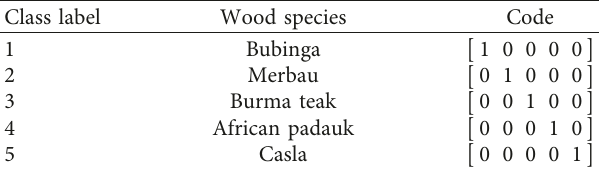
Table 2: Class label and code for 5 wood species in known category. Class label Wood